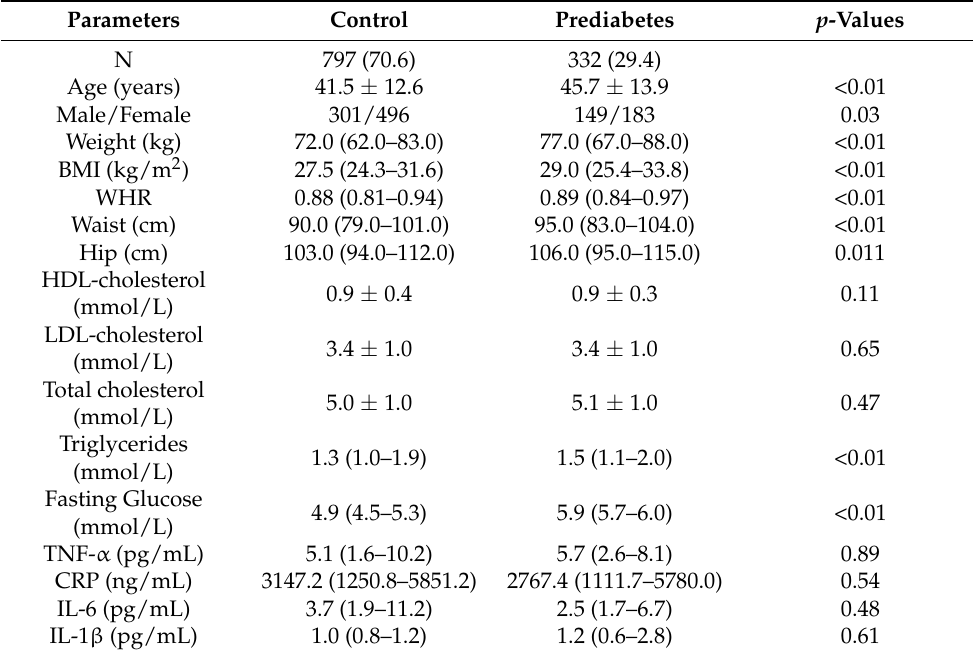
Table 1. Anthropometry and Clinical Characteristics of